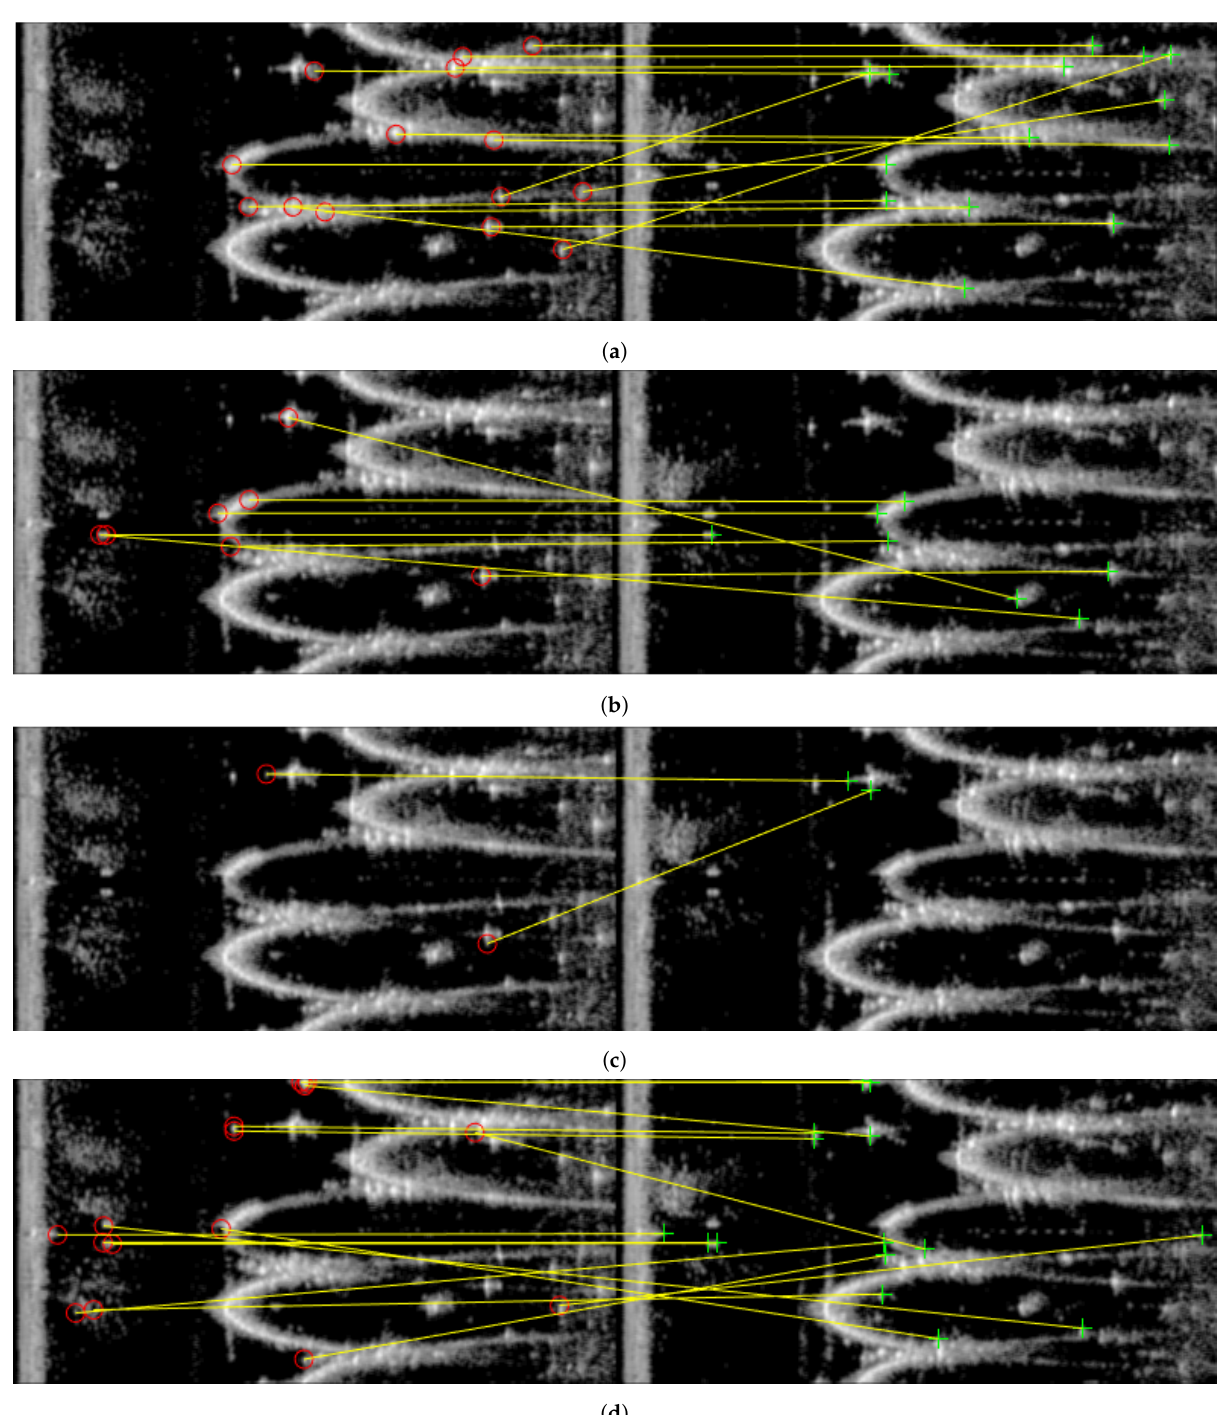
Figure 26. Feature points matched between images 5 and 6 of dataset 2 with the algorithms under analysis. This illustration corresponds to the information portrayed on the third entry of Table 6. ( a ) Feature matching with SURF algorithm, ( b ) feature matching with ORB algorithm, ( c ) feature matching with BRISK algorithm, and ( d ) feature matching with SURF-Harris